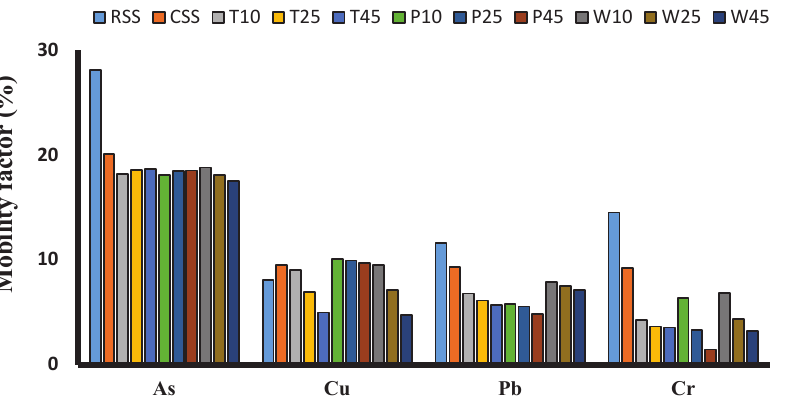
Figure 3: Mobility factor of As, Cu, Pb, and Cr in RSS and produced compost samples (Each abbreviation in legend is defined in Table 3).